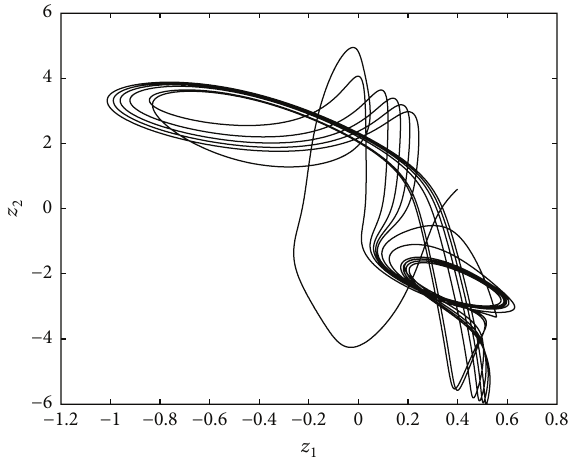
Figure 6: Trajectory of the delayed neural network